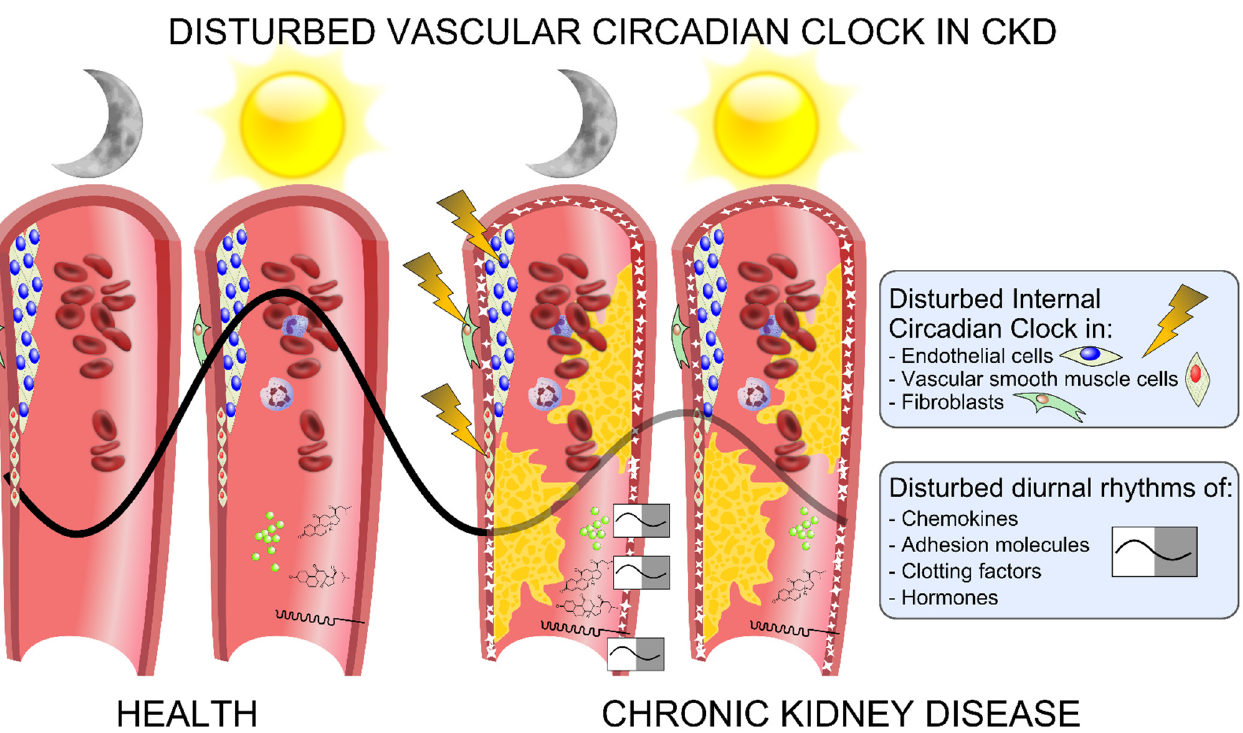
Figure 4. Graphic overview of the disturbances of the vascular circadian clock in chronic kidney disease (CKD). The circadian clock operates in the cells that comprise the vasculature, such as endothelial cells, VSMCs and fibroblasts. In CKD, the vascular circadian clock is disturbed and associated with a disturbance in the diurnal rhythm of chemokines and adhesion molecules such as VCAM-1 and ICAM-1, as well as of clotting factors, blood pressure, hormones and white blood cells, which may contribute to uremic vasculopathy by means of calcification, atherosclerosis, blood clotting, increased migration of immune cells into the vasculature and increased oxidative injury.